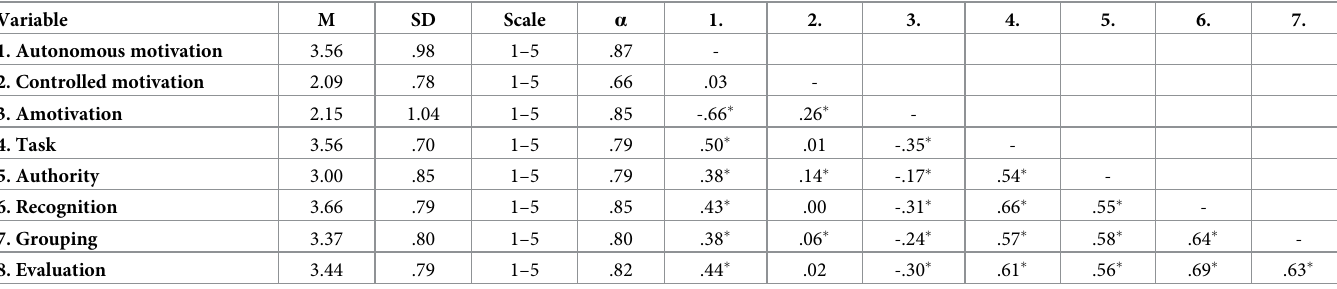
Table 1. Means, standard deviations, Cronbach’s alpha, and correlations of all study variables. Variable